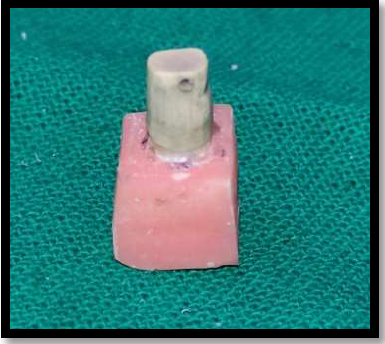
Figure 3. Coping seated on the specimen.